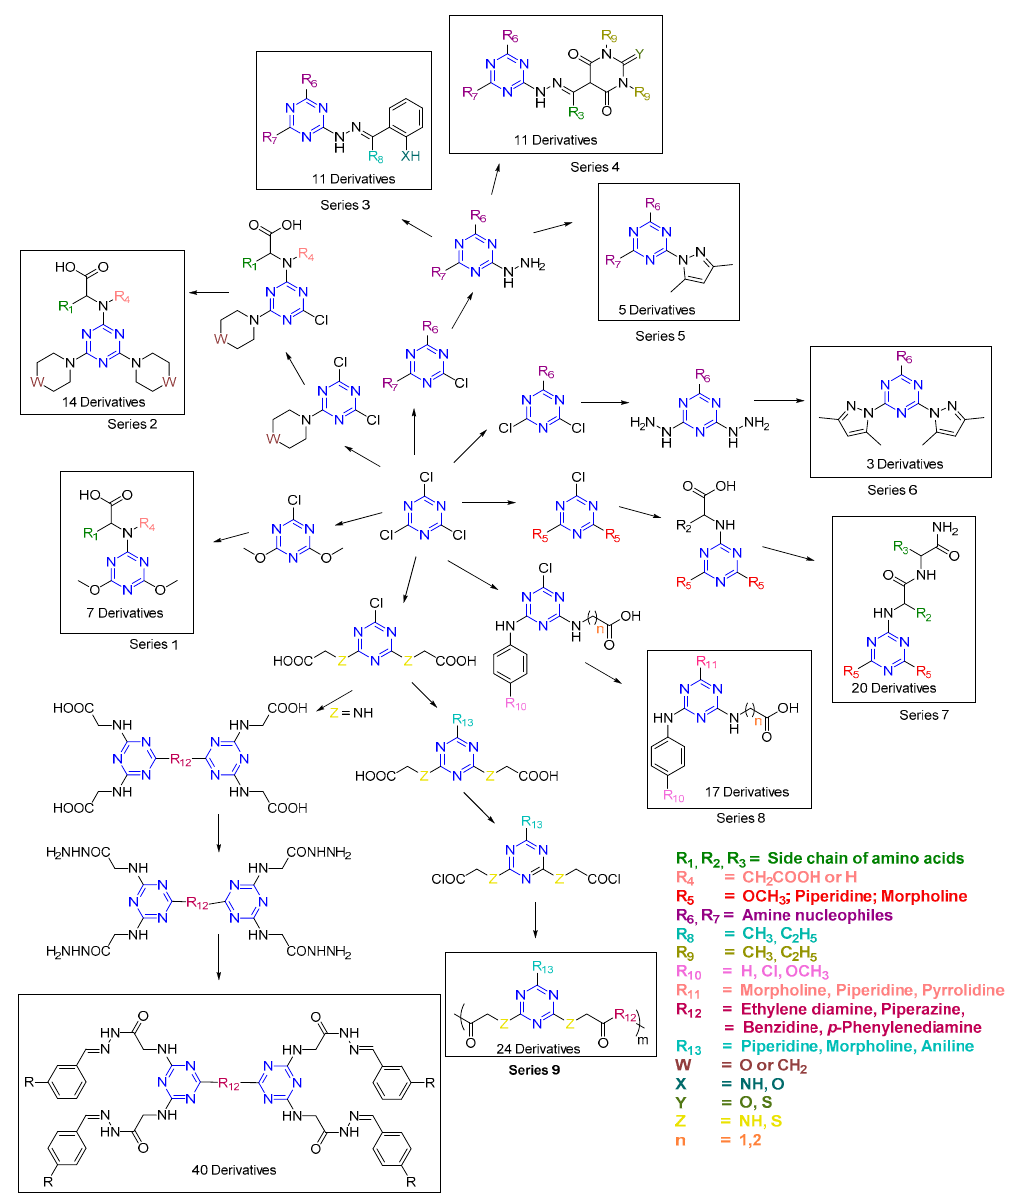
Scheme 1. Scheme for the synthesis of s-triazine